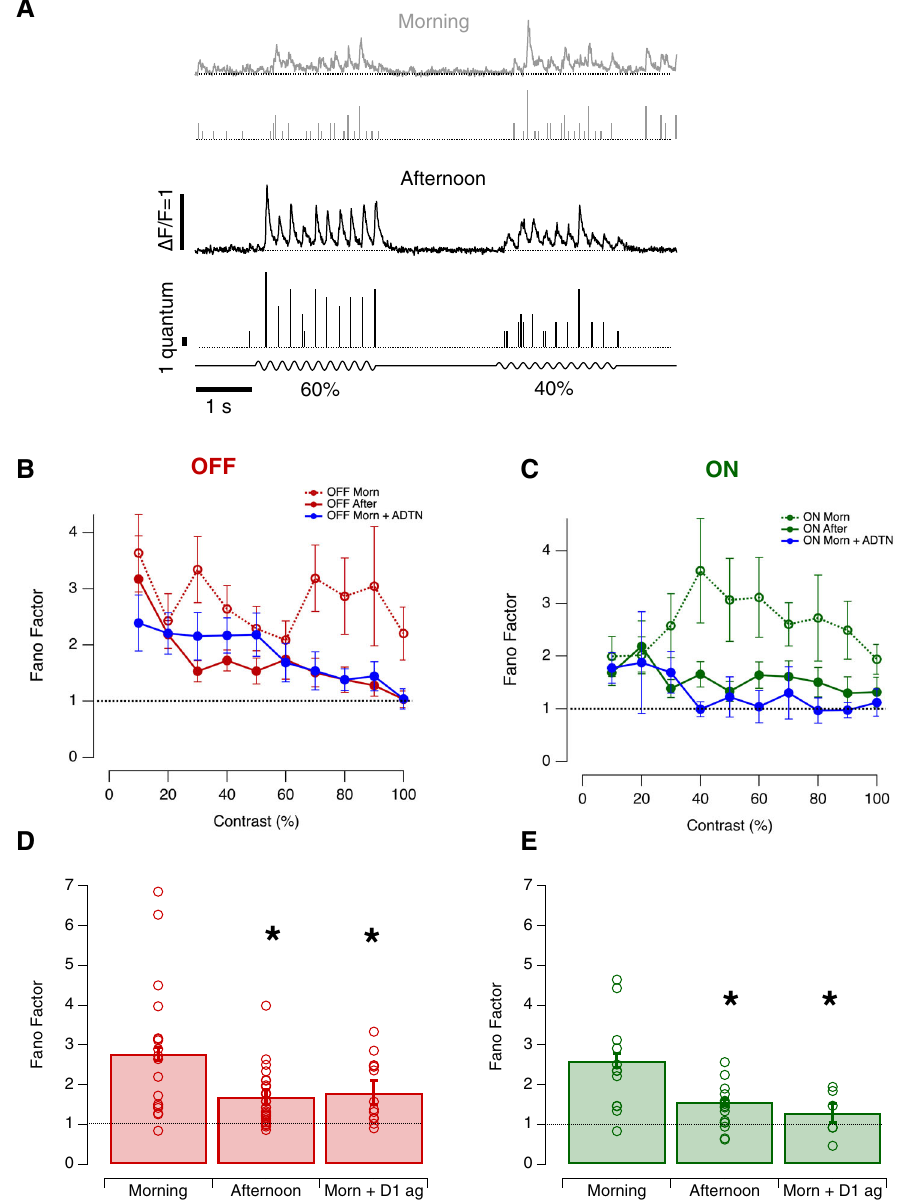
Fig. 5 Diurnal changes in the variability of stimulus-evoked responses. A Examples of iGluSnFR signals from individual OFF synapses in the morning and afternoon. Responses elicited by stimuli of 60% and 40% contrast varied from cycle to cycle of the 5 Hz stimulus. In each case the top trace shows the iGluSnFR signal and the lower trace the estimated Q e . B Variability in the response of OFF synapses calculated as the Fano factor, with each response measured as the total number of vesicles released over one cycle at each contrasts. Comparison is made between the morning ( n = 18), afternoon ( n = 27) and the morning after injection of ADTN ( n = 13). Each point shows the mean ± s.e.m. C As in B, but for ON synapses ( n = 12, 15 and 6 synapses for respective conditions). D Average Fano factor over different contrasts in OFF synapses in the three conditions described above. Data from ( B , C ). Overall, the average Fano factor was signi fi cantly higher in the morning compared to afternoon or in the morning after injection of ADTN (One-Way ANOVA; p < 0.0001). Open red dots represent individual values. Error bars show ± s.e.m. E As ( D ), but for ON synapses. Again, the average Fano factor was signi fi cantly higher in the morning (One-Way ANOVA; p < 0.0001). Open green dots represent individual values. Error bars show ± s.e.m. Source data are provided as a Source Data fi